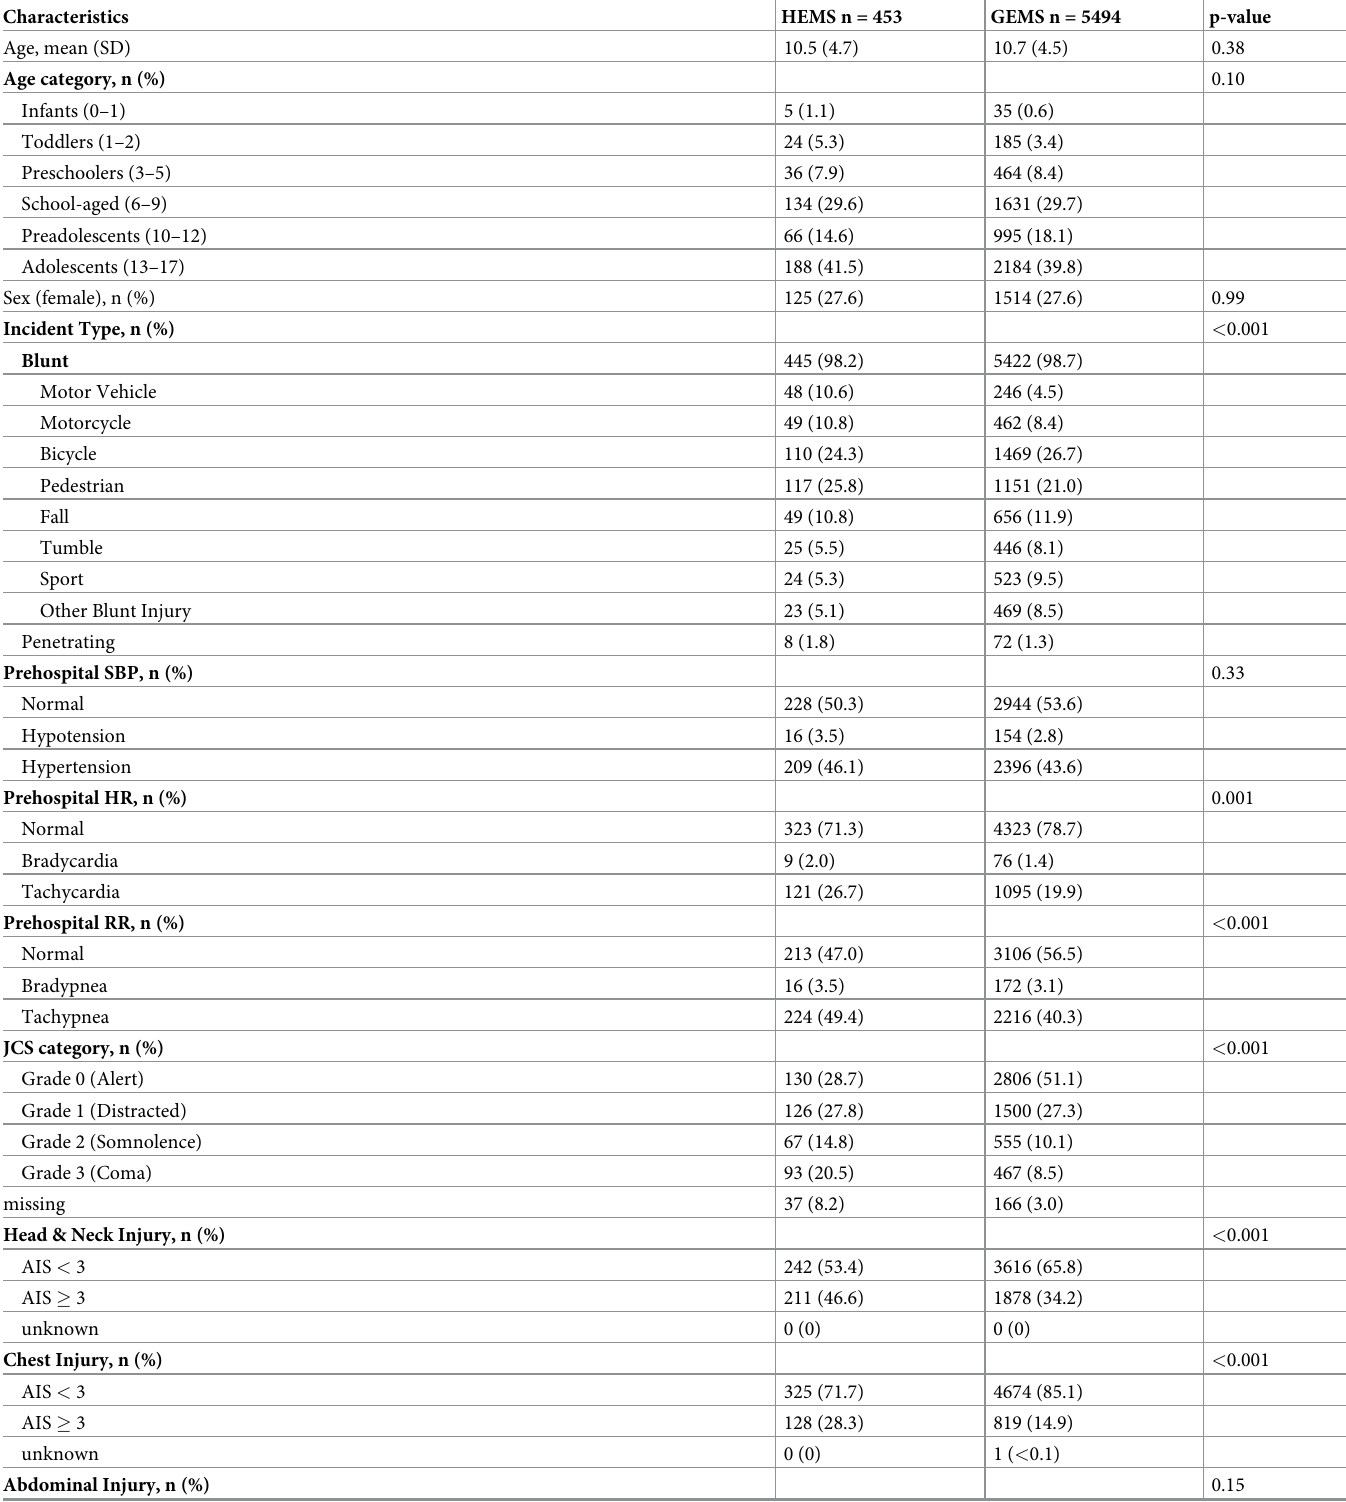
Table 1. Characteristics of children transported by emergency medical services.